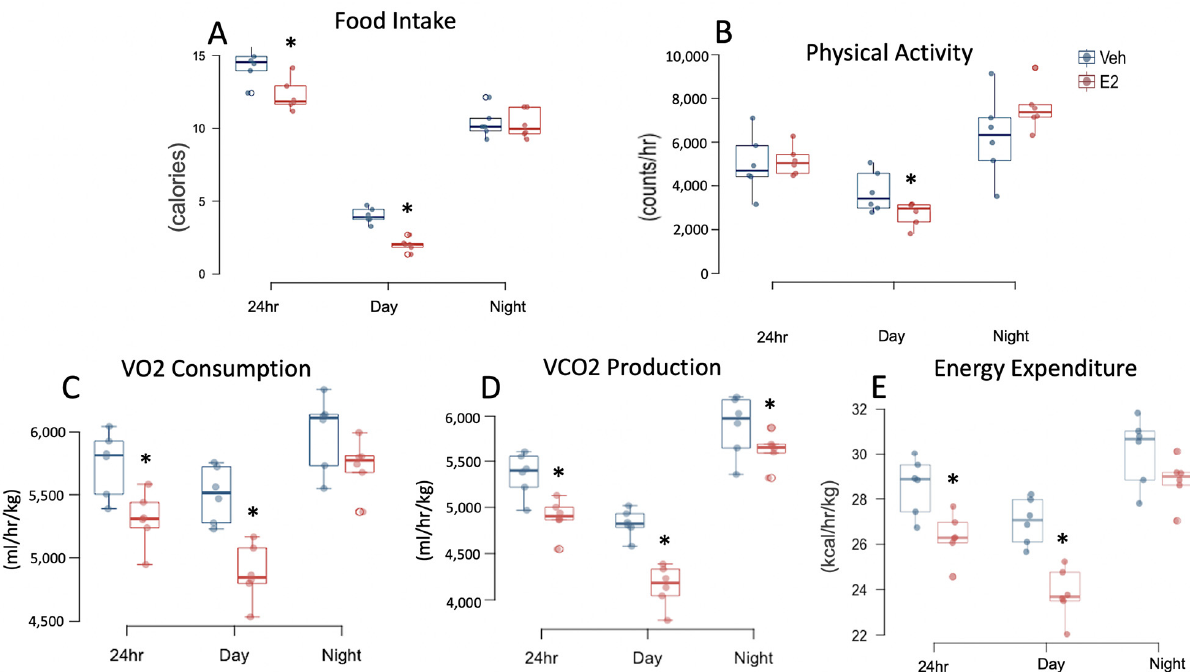
Figure 2. Estradiol decreases food intake and energy expenditure in female mice fed a STND. Data for Food intake ( A ) Physical activity ( B ) VO2 consumption ( C ) VCO2 production ( D ) Resting energy expenditure ( E ) were collected from mice in metabolic cages on days 11–13. The average 24-h data were obtained from 72-h data and used for statistical analysis. * indicates differences between E2 and Veh mice (n = 6/group) ( p < 0.05; t -test).